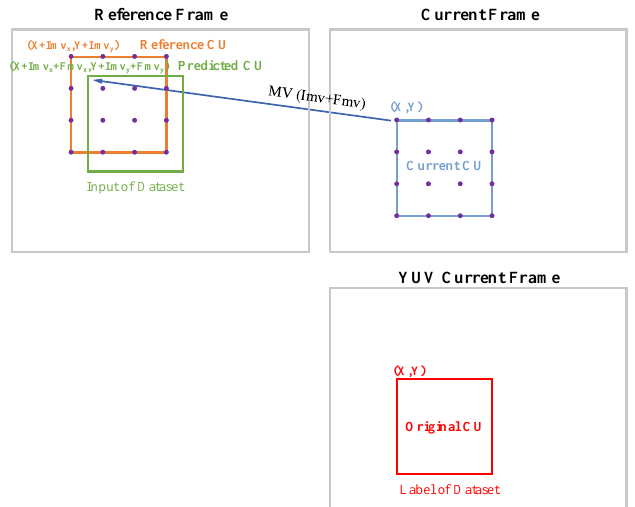
Figure 7. Illustration of the process of generating training data for training the